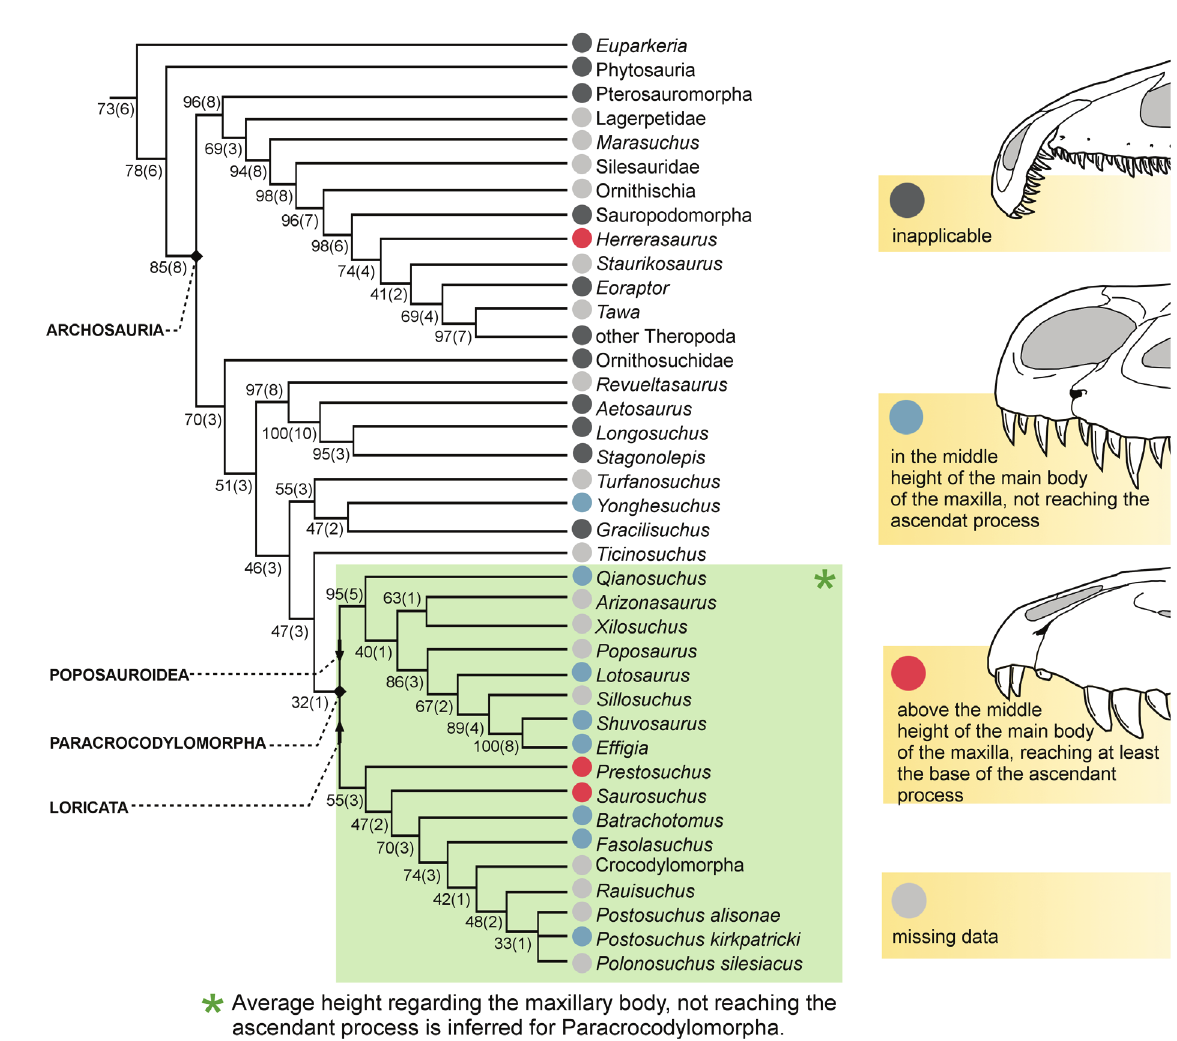
Figure 6 - Simplified strict consensus of 81 MPTs depicting the distribution of the new character among the OTUs. Numbers associated with nodes represent Bootstrap values and Bremer support (between